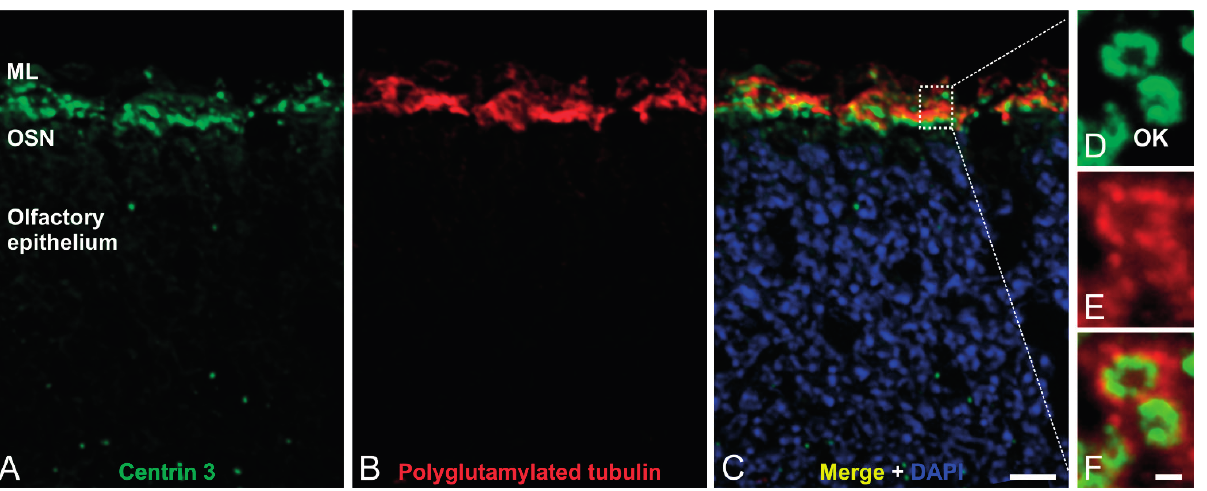
Figure 4. Immunofluorescence analysis of olfactory cilia in the mouse olfactory